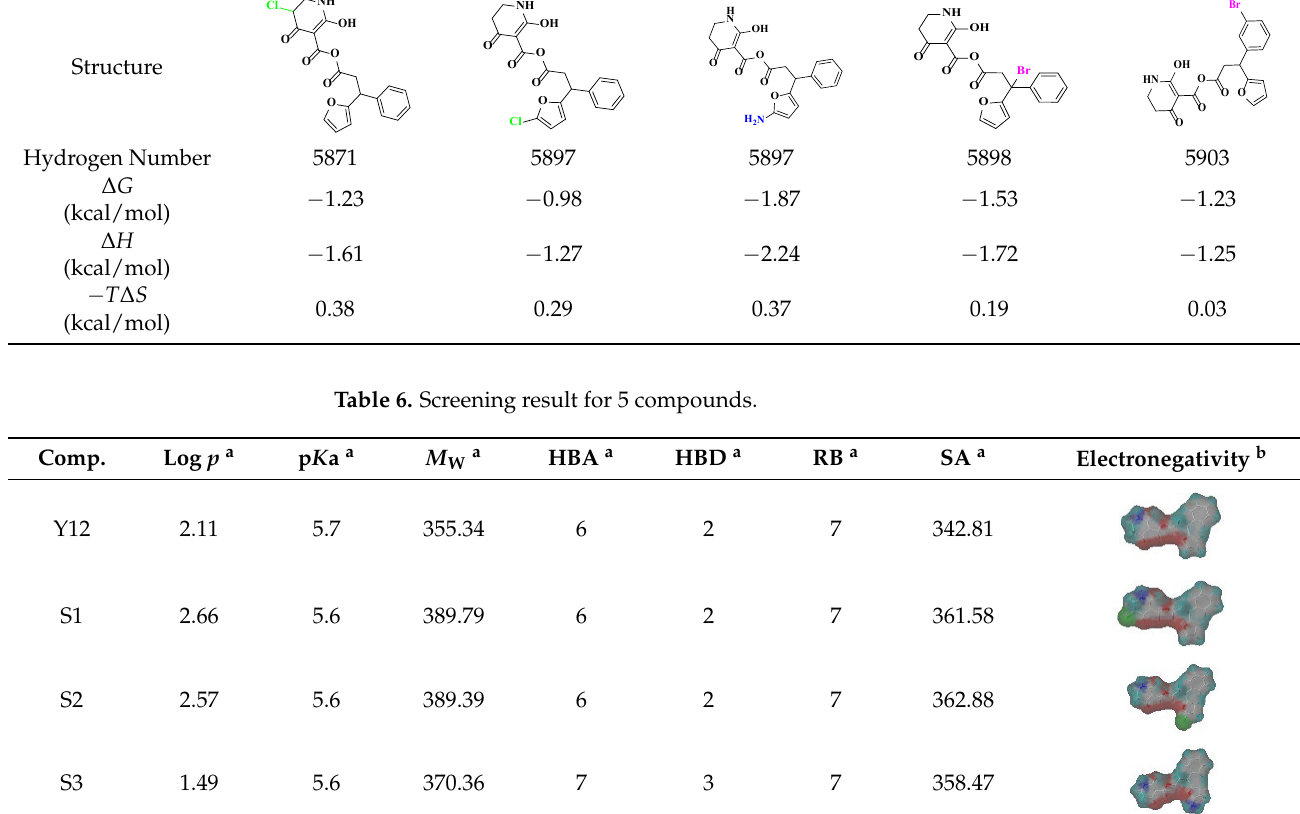
Table 5. Screening result for 5 compounds.